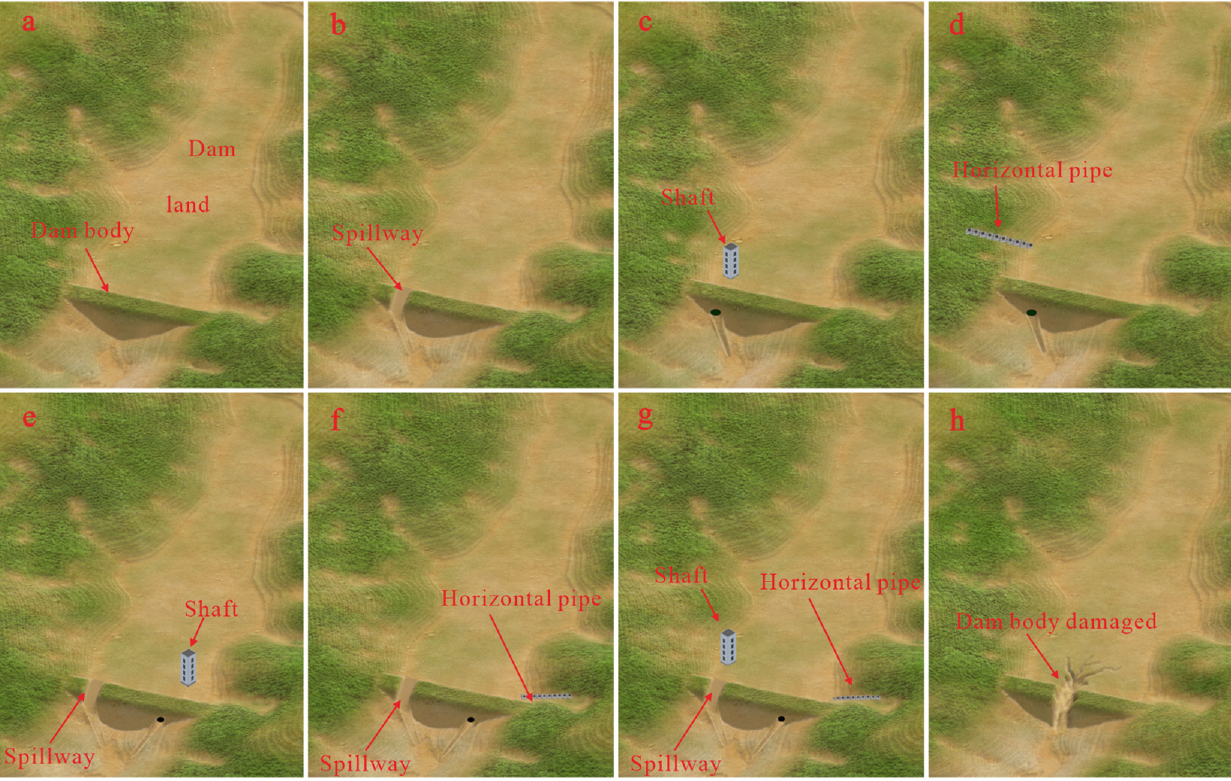
Figure 2. Different connection modes of check dams with a downstream channel.